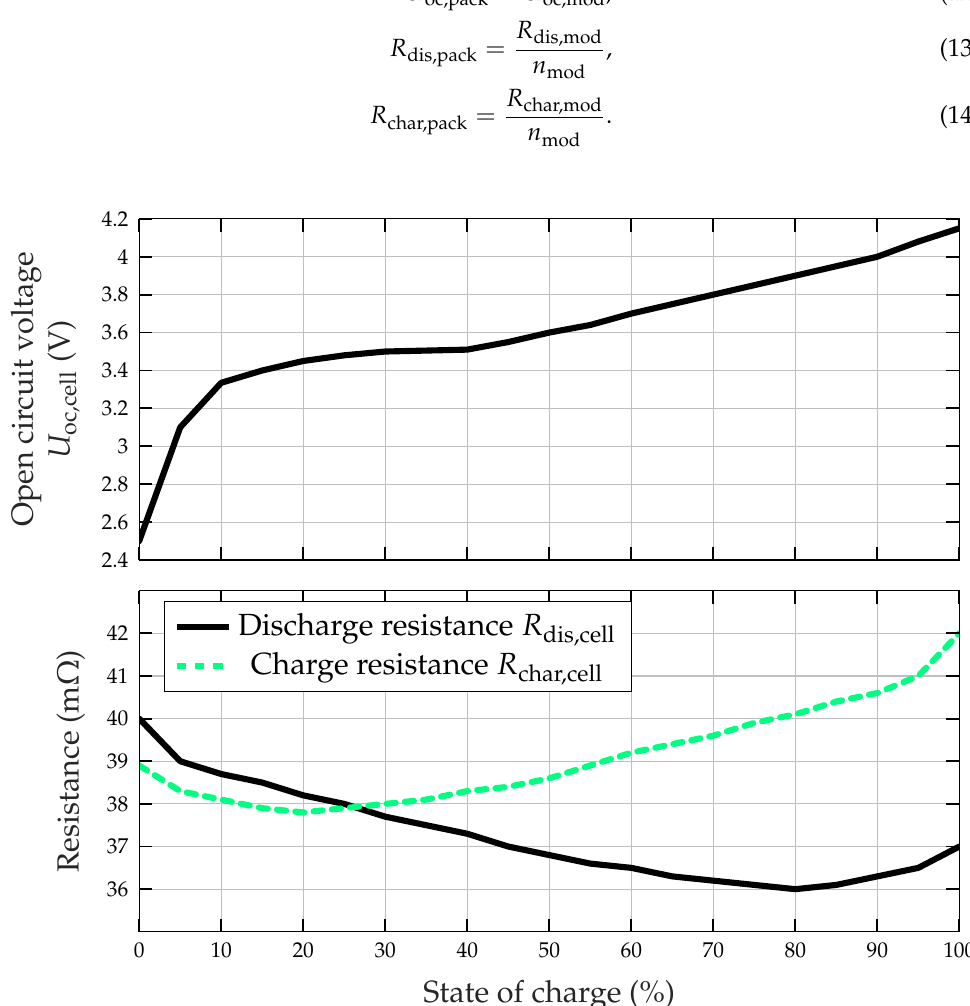
Figure 6. Open-circuit voltage and resistance characteristics of the Panasonic cell of the type NCR18650B.